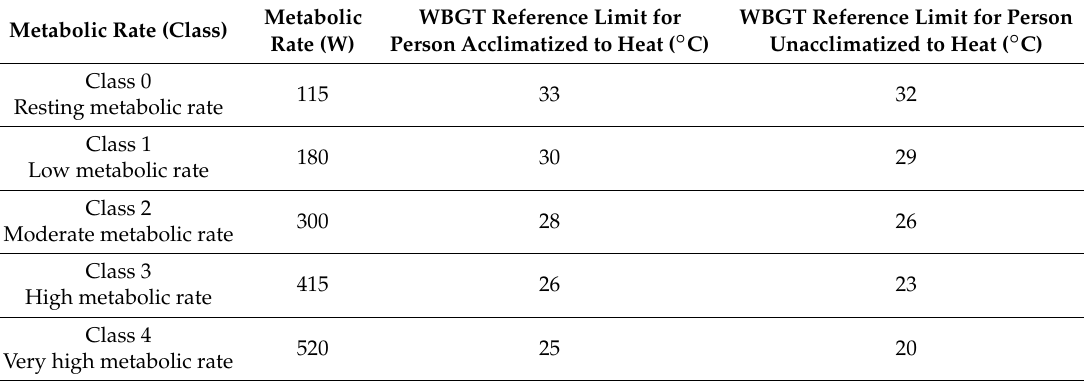
Table 1. Recommended Wet Bulb Globe Temperature (WBGT) eff reference values for acclimatized and unacclimatized people for five classes of metabolic rate, modified on the basis of